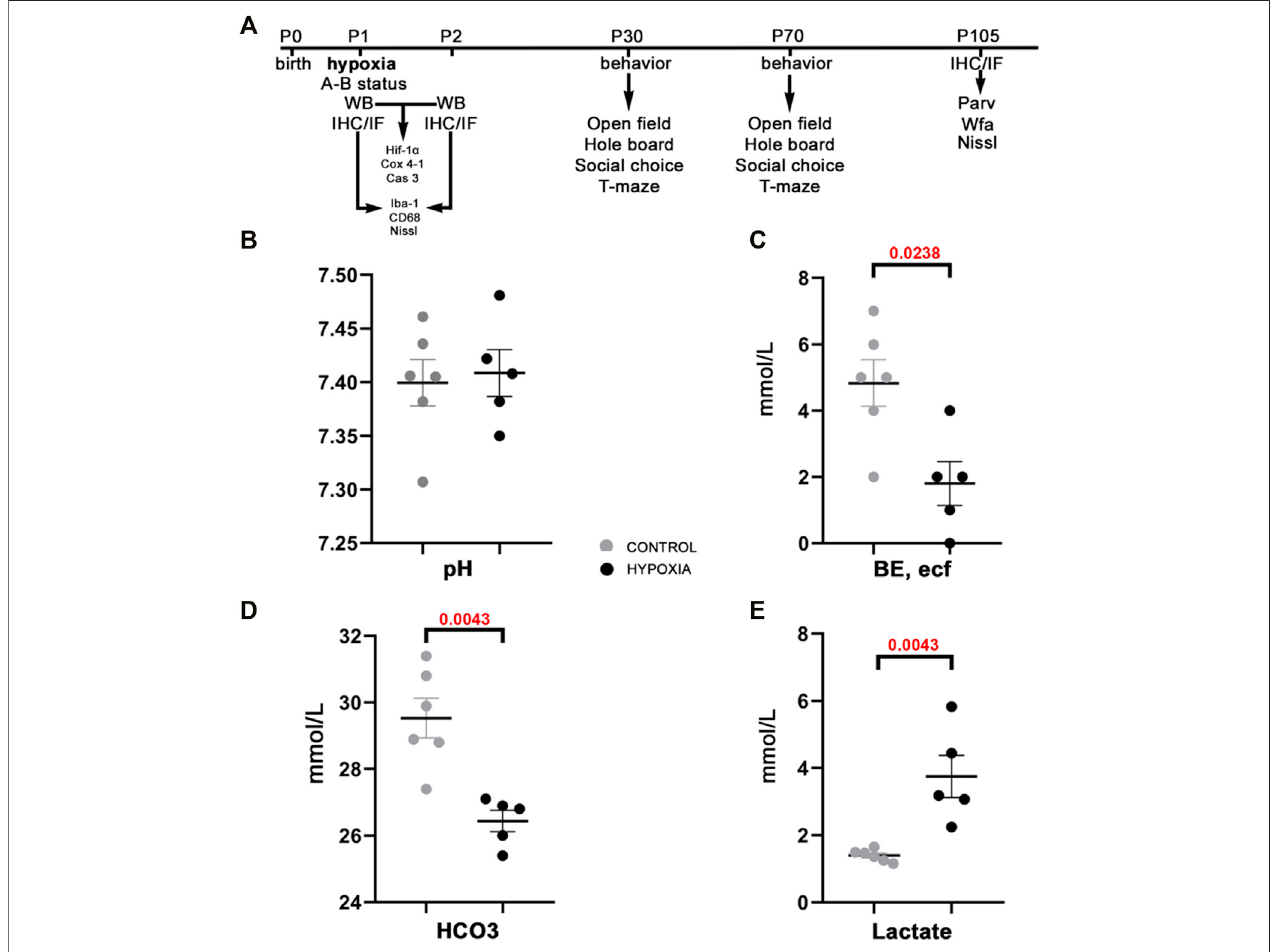
FIGURE1| Thestudydesignandacid-basestatusoftheanimalsindicatesuf fi cientcompensatorybufferscapacity,ensuringacid-basehomeostasisatthisdesign ofmoderateperinatalhypoxia inrat. (A) Apresentationofthestudydesignbytimelinewiththetimepointschosenfordataacquisitionbyvarioustests, staining ’ sofbrain tissuesections, and subsequent qualitative and quantitative analysis ofthe behavior and brainstructures. Treated and control animal distribution per each experiment is presentedin SupplementaryTableS1 .Thetreatedratsweresubjectedtohypoxia(during2 h)atP1.Immediatelyafter,someweresacri fi cedtomeasuredifferent parameters of A-B status. Other animals were sacri fi ced later at 8 h, and 24 h after hypoxia for brain samples, on which WB, IF, IHC were employed with different antibodies.Theantibodiesusedinthestudyarelistedin Table1 .Theremainderoftheanimalsweretestedattwodifferentagepoints:startingatP30andP70during fi ve subsequentdays.Theanimalsweretestedwithfourbehavioraltests(open fi led,holeboard,socialchoice,T-maze).Theseanimalsweresacri fi cedatP105toisolatethe brain tissue for differential staining ’ s and further data acquisition. (B – E) The values of different blood parameters showing acid-base status measured immediately after hypoxia. (B) The pH (hydrogen potential) valuesspeak infavor ofsuf fi cient compensatorycapacitythatameliorateselectrolyte imbalance in therat neonates. (C) BE, ecf (base excess in the extracellular fl uid) show signi fi cantly lower values in the hypoxic animals due to depletion ofbase buffers for compensation ofthe metabolic acidosis. (D,E) The